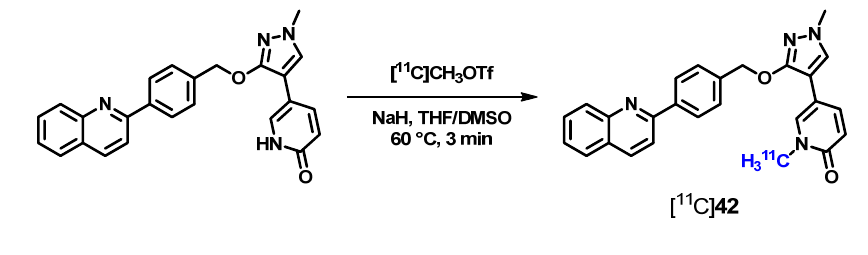
Scheme 12. Radiosynthesis of [ 11 C] 42